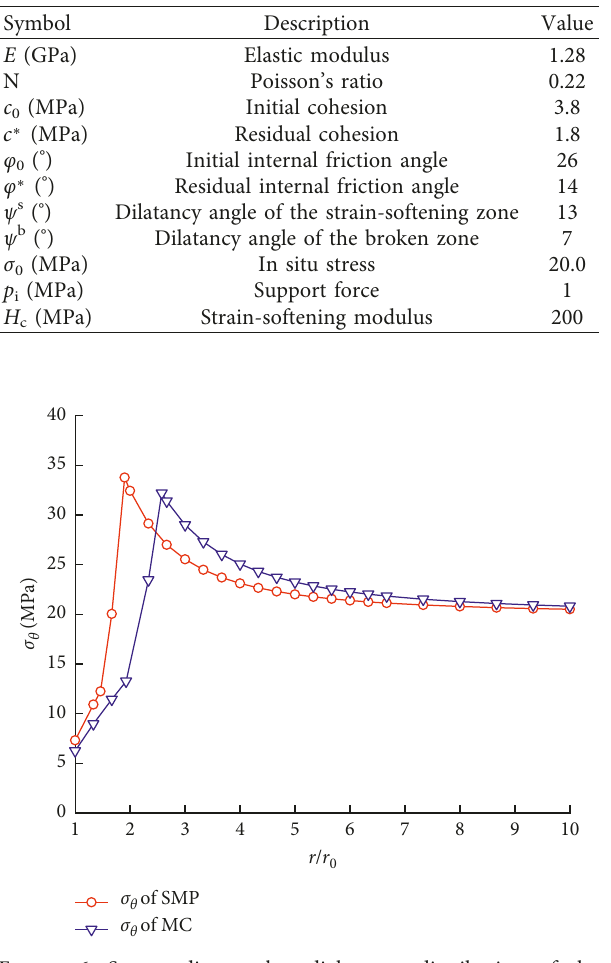
Figure 6: Surrounding rock radial stress distribution of the Mohr–Coulomb and SMP criteria.